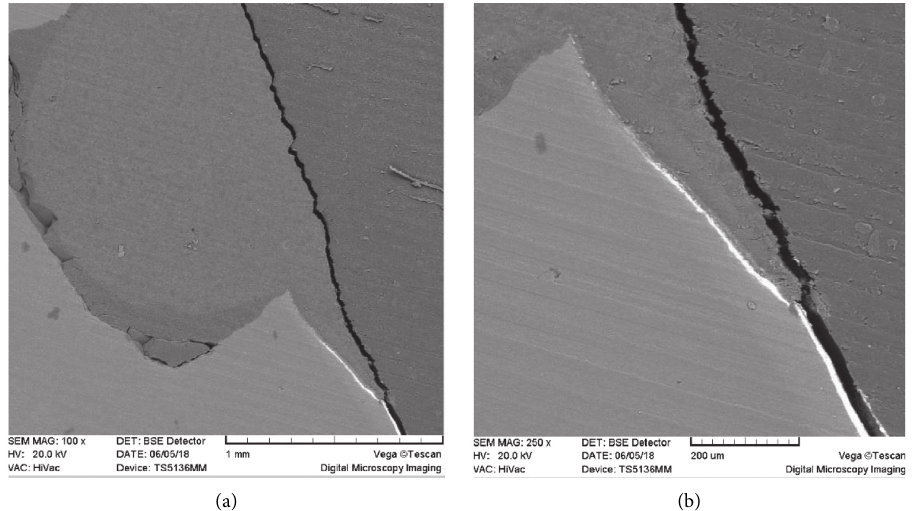
Figure 6: Marginal leakage of the gingival wall at different SEM magnifications. (a) 100x magnification. (b) 250x